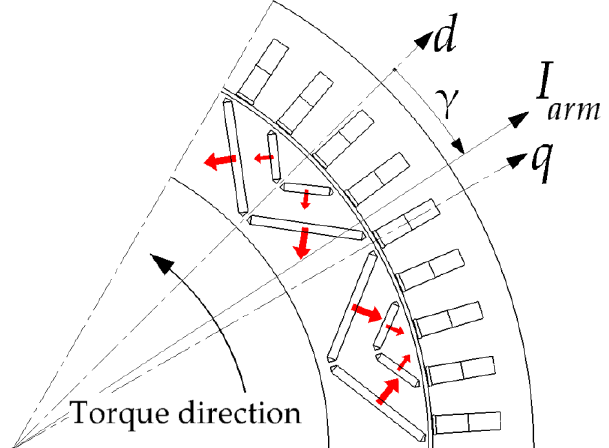
Figure 4. Computational area of the IPMSM. Red arrows show the magnetization directions of permanent